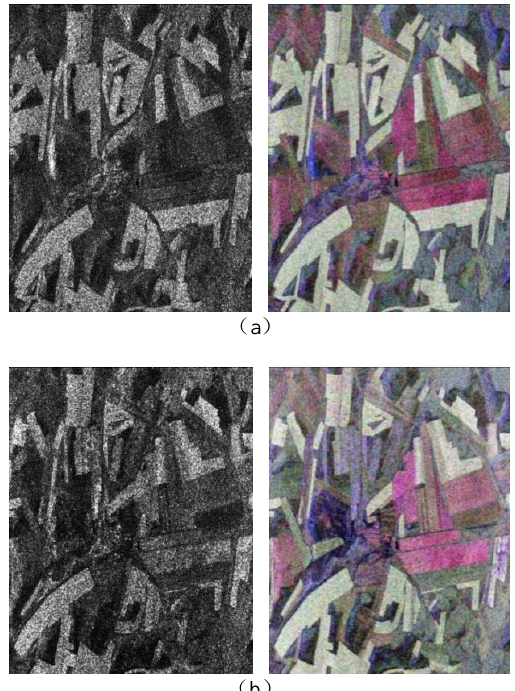
Figure 3. HH polarization and Pauli synthesis of SAR images after preprocessing, (a) Image 1, (b) Image 2 The targets response is usually anisotropic of SAR